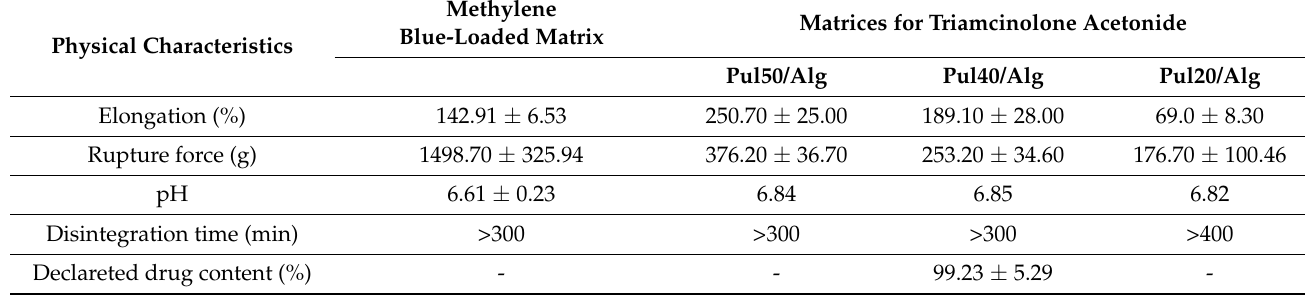
Table 9. Physicochemical characteristics of the evaluated matrices. Data are presented as the mean ± SE. n =